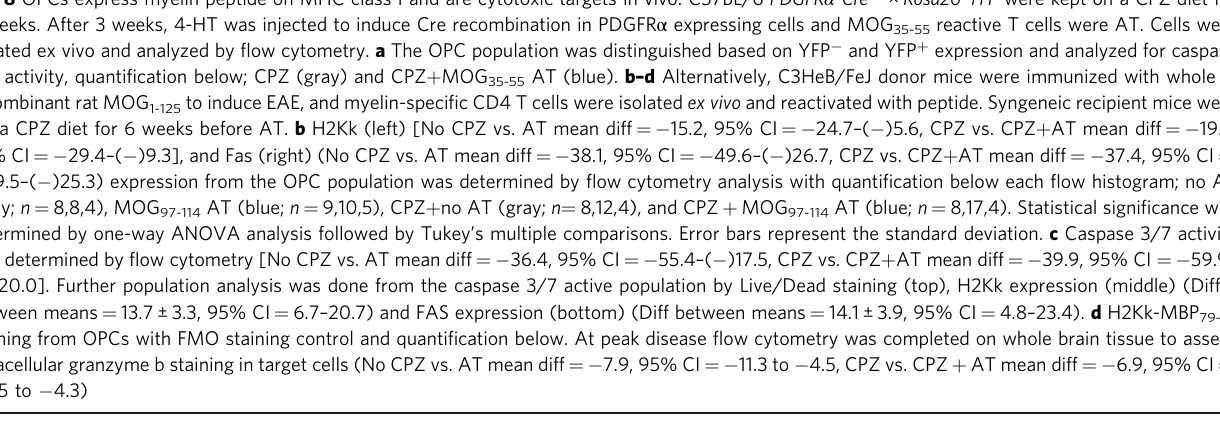
Fig. 8 OPCs express myelin peptide on MHC class I and are cytotoxic targets in vivo. C57BL/6 PDGFR α -Cre ER × Rosa26-YFP were kept on a CPZ diet for 4 weeks. After 3 weeks, 4-HT was injected to induce Cre recombination in PDGFR α expressing cells and MOG 35-55 reactive T cells were AT. Cells were isolated ex vivo and analyzed by fl ow cytometry. a The OPC population was distinguished based on YFP − and YFP + expression and analyzed for caspase 3/7 activity, quanti fi cation below; CPZ (gray) and CPZ + MOG 35-55 AT (blue). b – d Alternatively, C3HeB/FeJ donor mice were immunized with